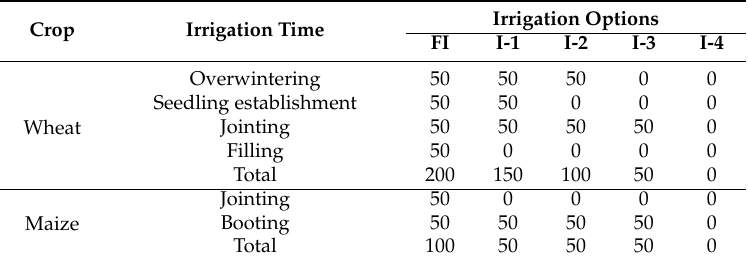
Table 2. Irrigation options for the wheat-maize rotation system (mm). FI, farmers’ irrigation volume; I-1, Irrigation Level 1.